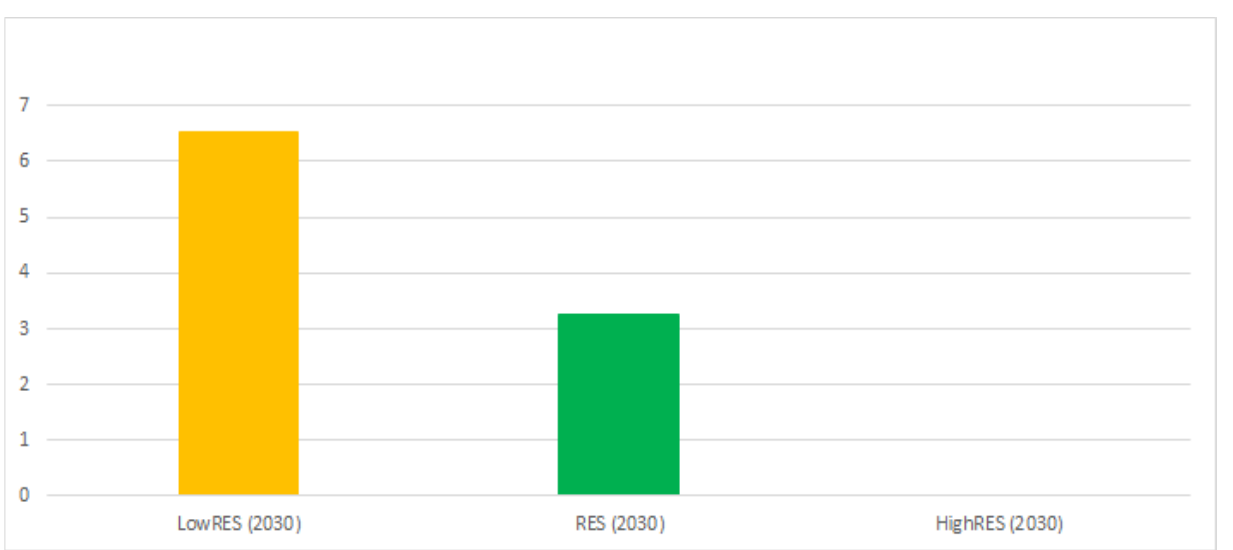
Figure 11. Comparison of GHG emissions for all scenarios as compared to the base year GHG emissions.